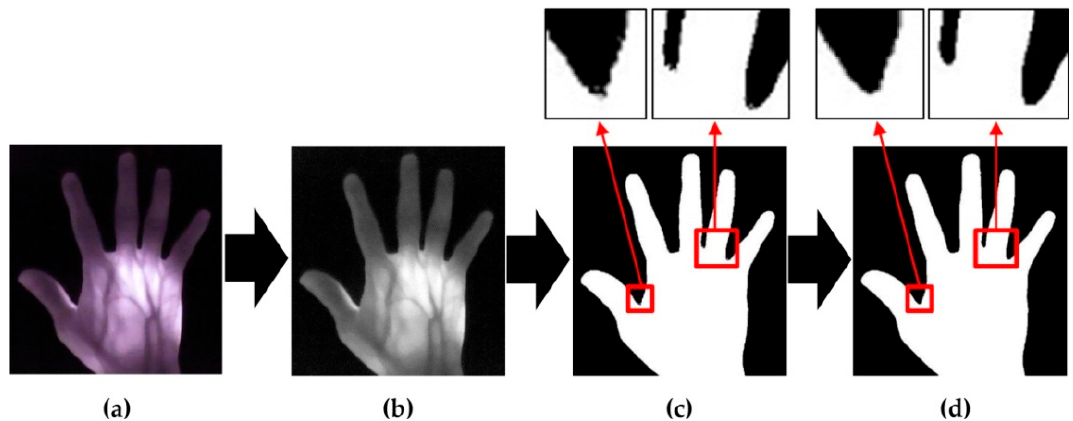
Figure 3. Image preprocessing: ( a ) original image, ( b ) gray scale image, ( c ) binarized image using the global threshold, ( d ) segmentation output image.